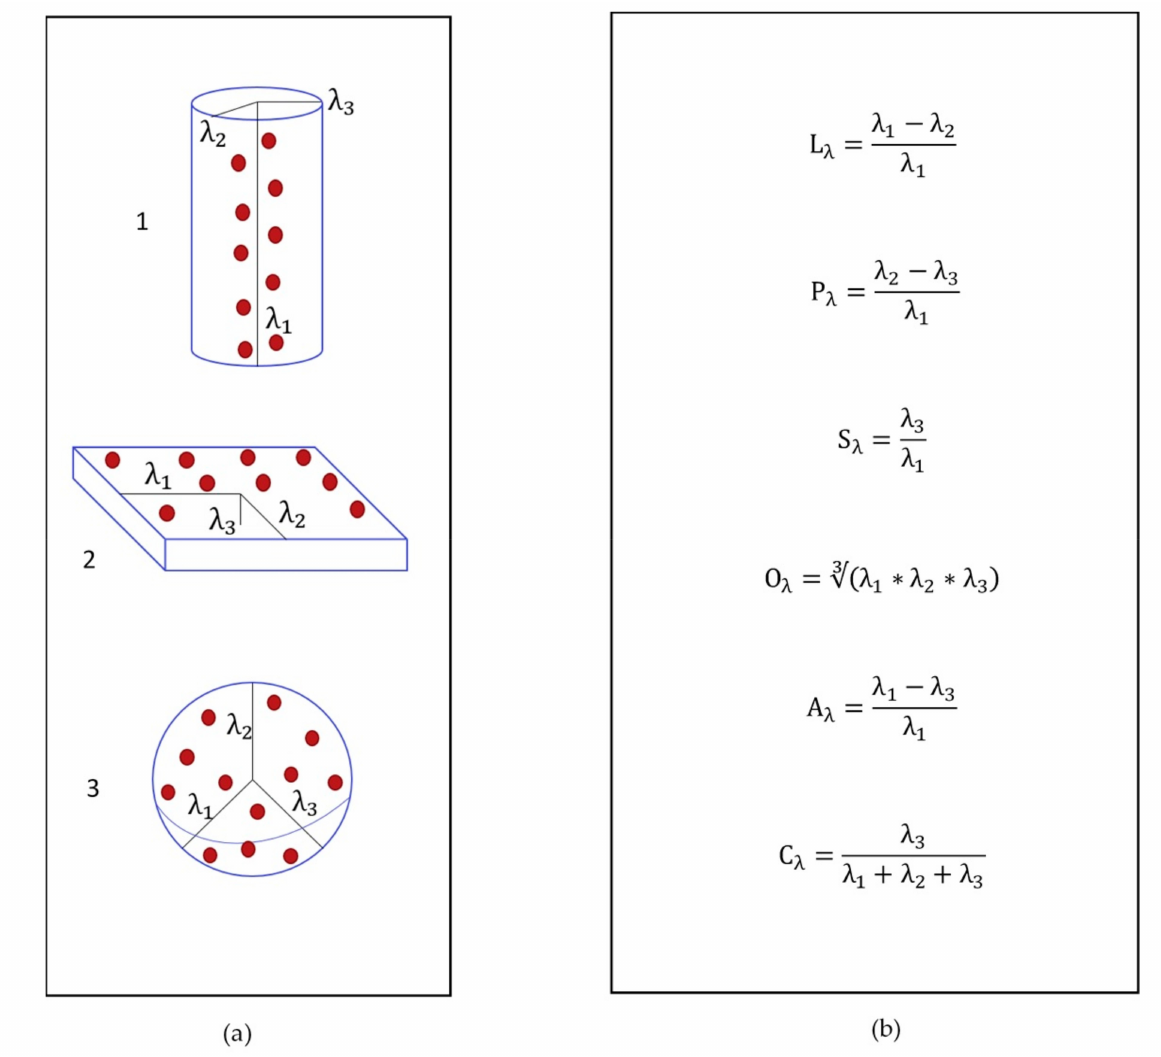
Figure 4. ( a ) Visualization of (1) linearity, (2) planarity, and (3) sphericity (after [43]). ( b ) Equation for linearity (L λ ), planarity (P λ ), sphericity (S λ ), omnivariance (O λ ), anisotropy (A λ ), and change of curvature (C λ